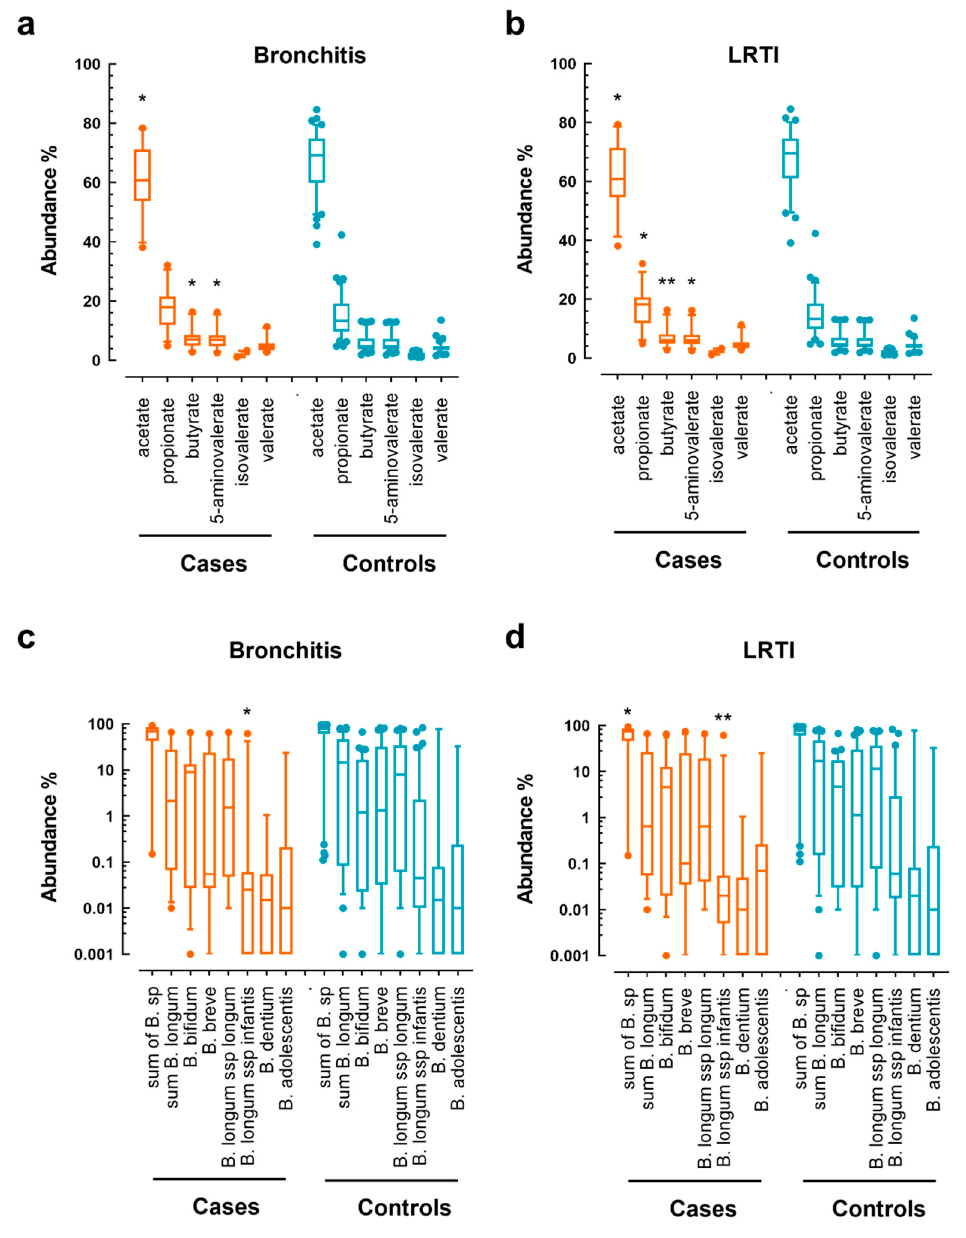
Figure 5. Comparison of relative amounts of short-chain fatty acids and Bifidobacterium species in the stool of infants at three months of age between infants who did not (controls) or did (cases) experience any bronchitis and LRTI thereafter from 3 to 12 months of age: ( a , b ) relative abundance of the short-chain fatty acids for bronchitis or LRTI cases and controls; ( c , d ) relative abundance of the Bifidobacterium species for bronchitis or LRTI cases and controls (* indicate p < 0.05, ** p < 0.01 by non-parametric t -test).